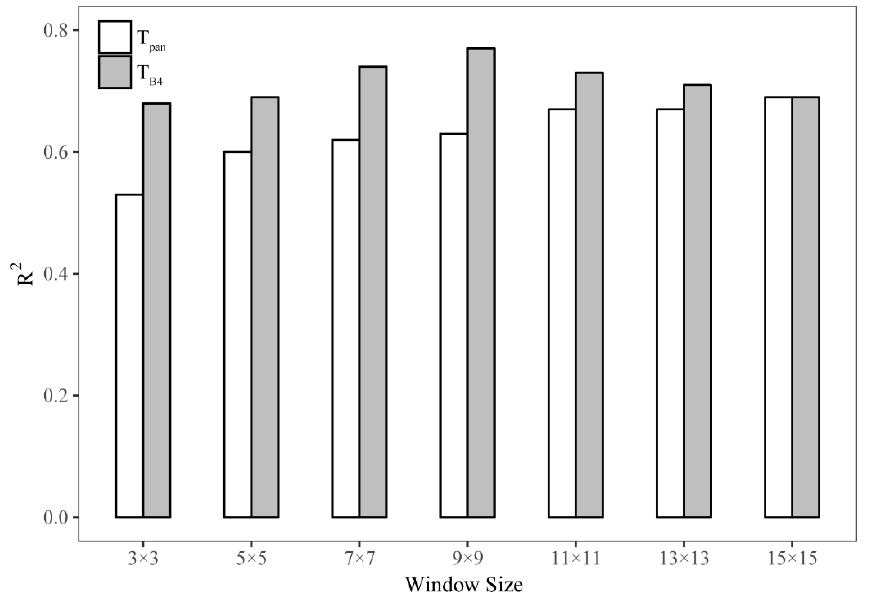
Figure 2. Illustration of the window size effect on the prediction of the forest CC (based on texture calculated from panchromatic image and Band 4).